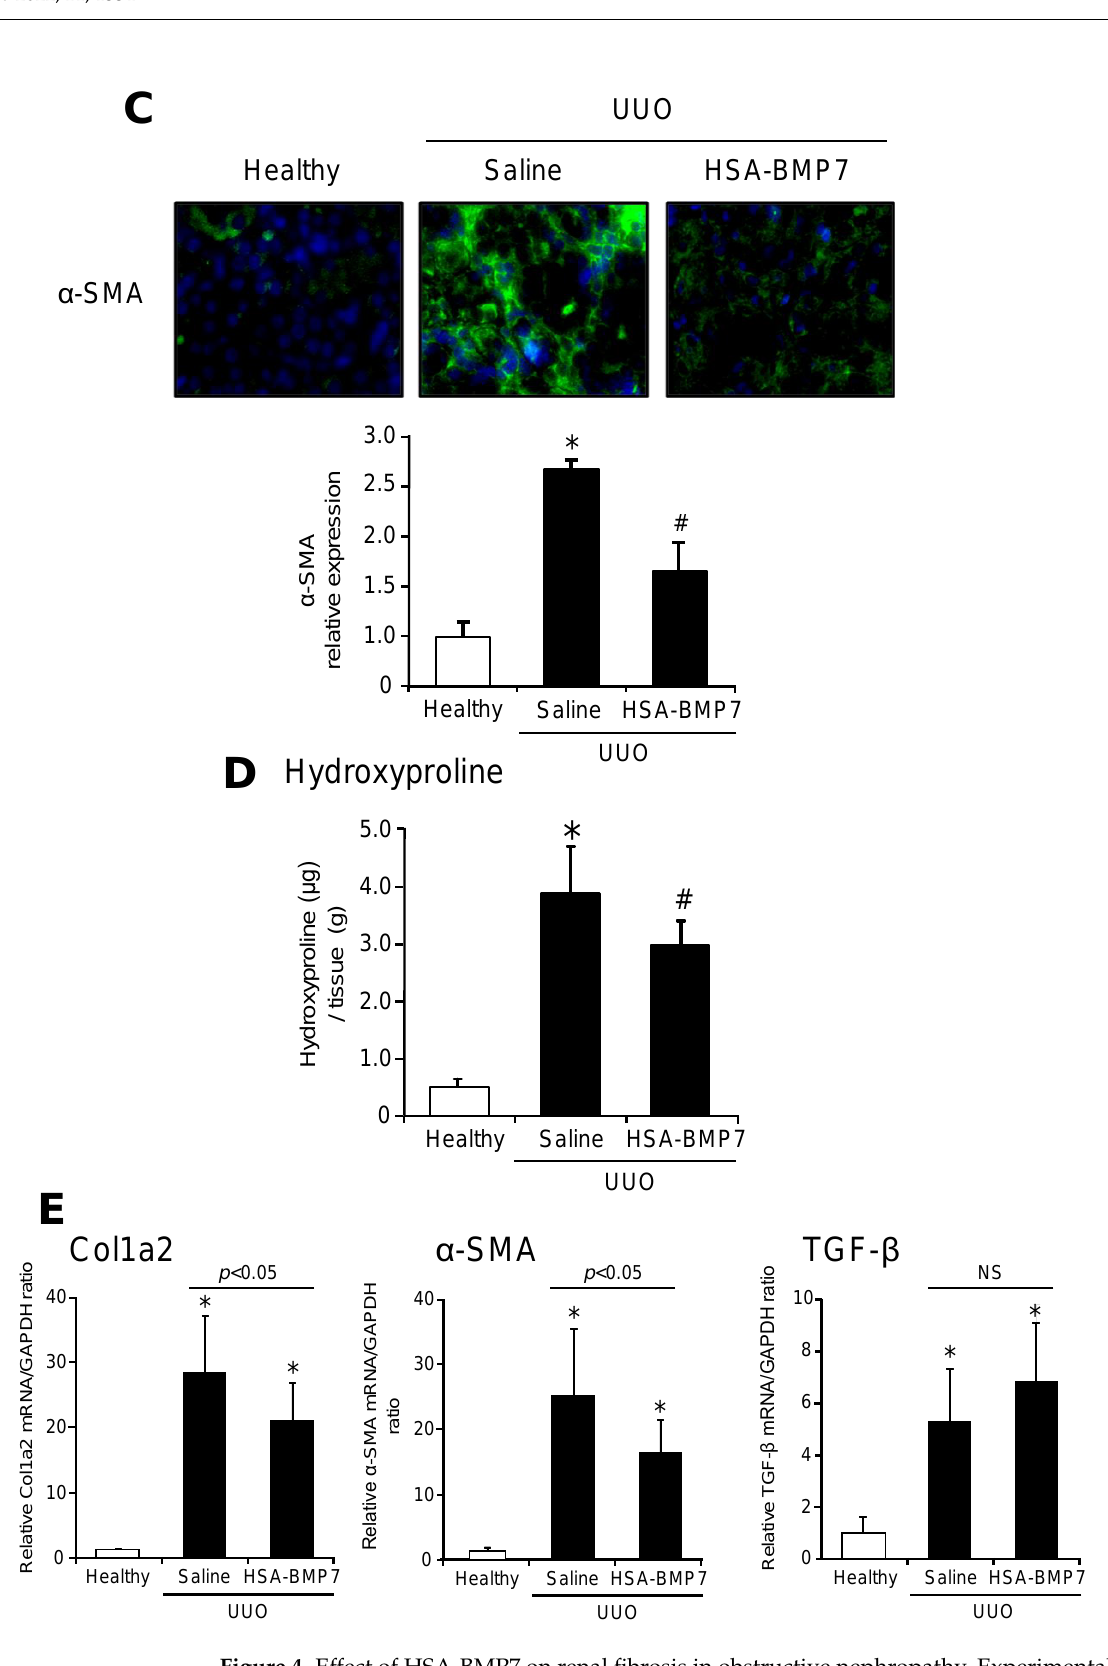
Figure 4. Effect of HSA-BMP7 on renal fibrosis in obstructive nephropathy. Experimental protocol for studying the effect of HSA-BMP7 against unilateral ureteral obstruction (UUO) induced renal fibrosis in mice ( A ). ICR mice underwent unilateral ligation. Two ligatures, 5 mm apart, were